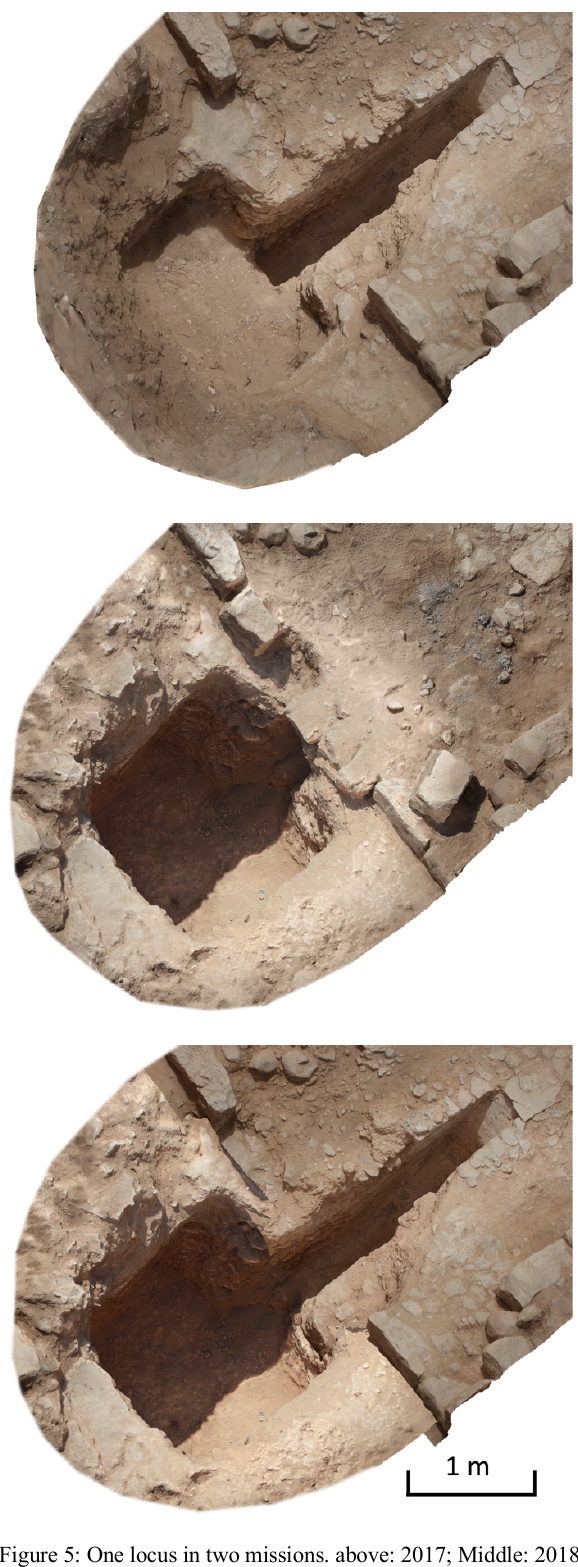
Figure 5: One locus in two missions. above: 2017; Middle: 2018 and below: 3D fusion of 2